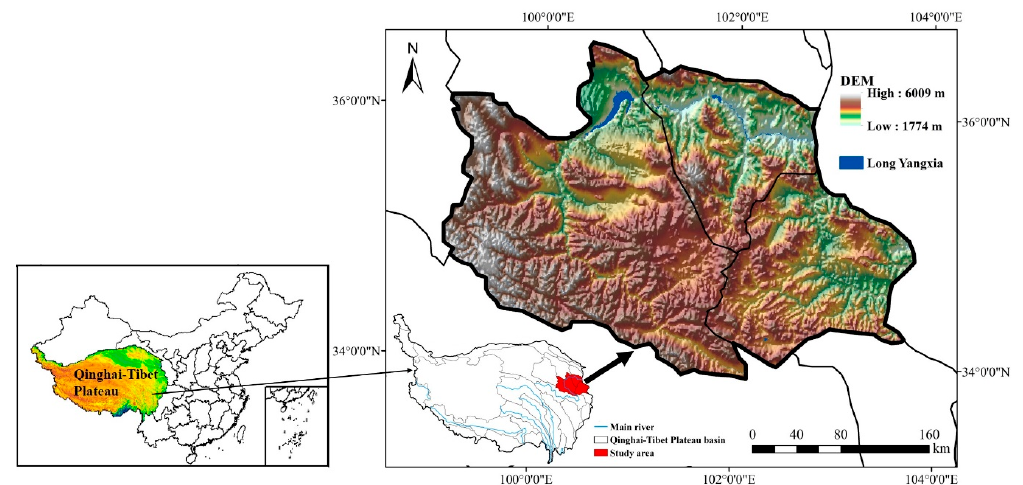
Figure 1. Spatial location of the study area.